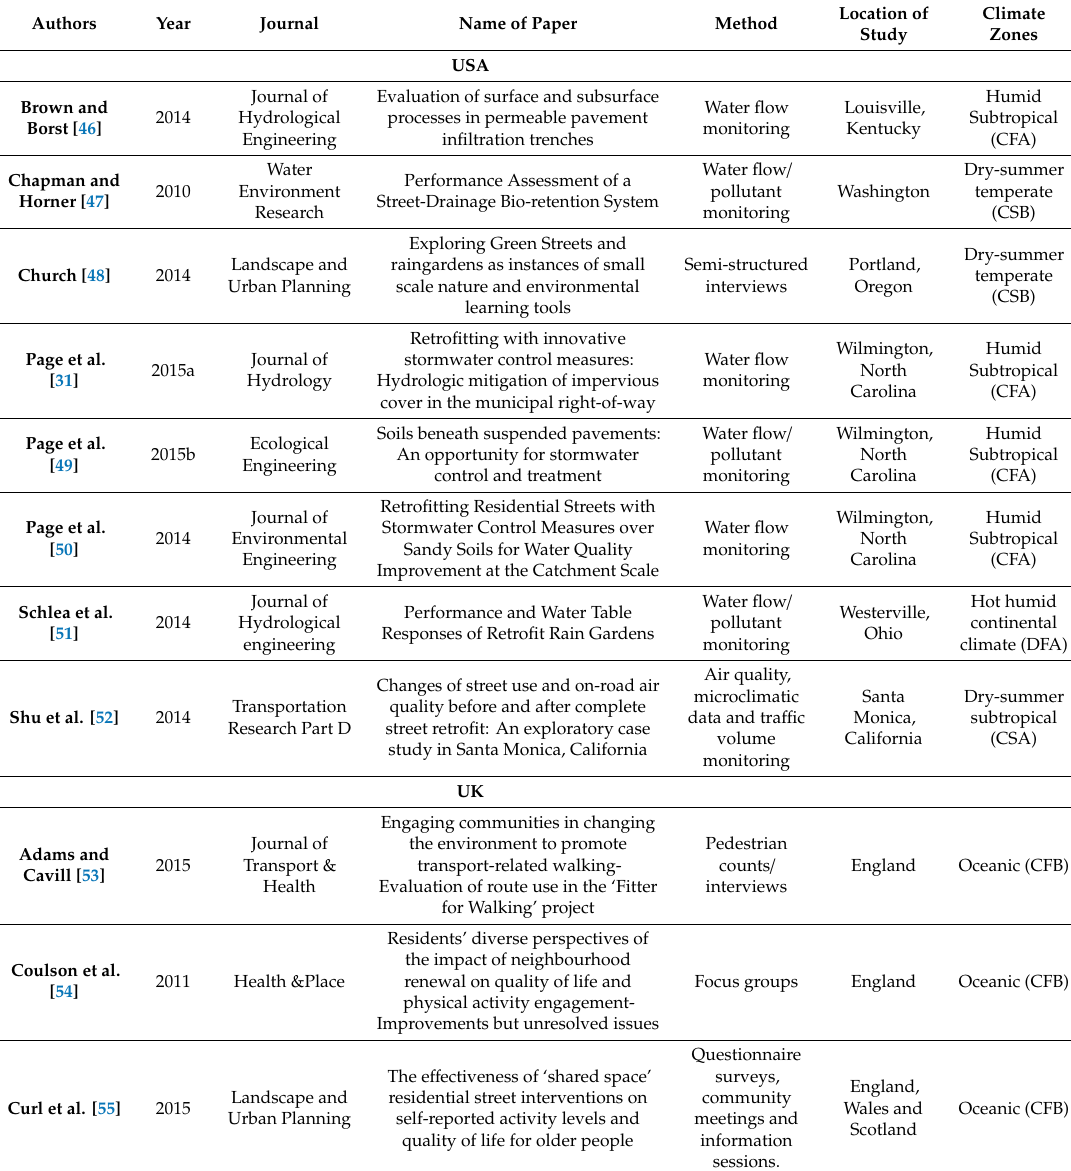
Table 1. Papers identified in systematic literature